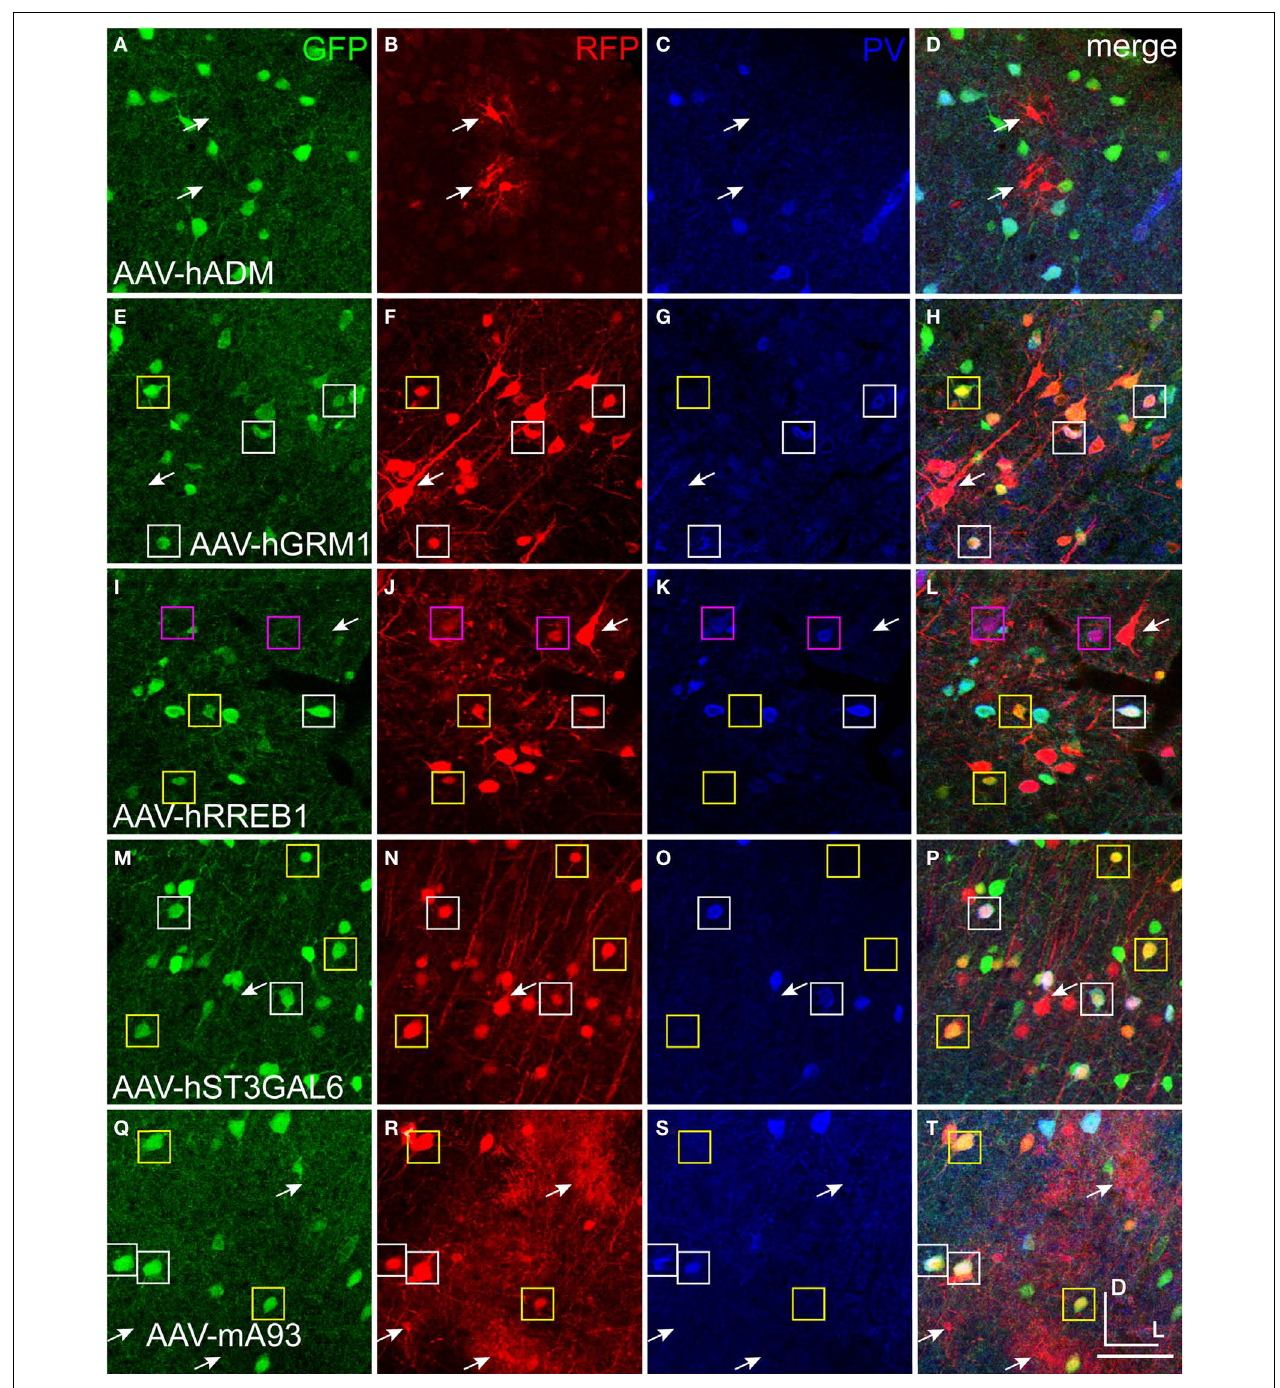
FIGURE 11 | Mammalian conserved TFBS promoters drove expression in mouse brain. GAD67-GFP knock-in mice were injected with AAV expressing RFP driven by promoter sequences with presumed cell-type specifi c regulatory elements. Images in each row are images of the same section. Green label in the fi rst column on the left (A,E,I,M,Q) is inhibitory neuron specifi c GAD67-GFP expression. Red label in the second column from the left (B,F,J,N,R) is RFP virus expression. Blue label in the third column from the left (C,G,K,O,S) is parvalbumin (PV) antibody label. The right column (D,H,L,P,T) is the merge of the previous columns. Overlap of green and red is yellow; green and blue is teal; red